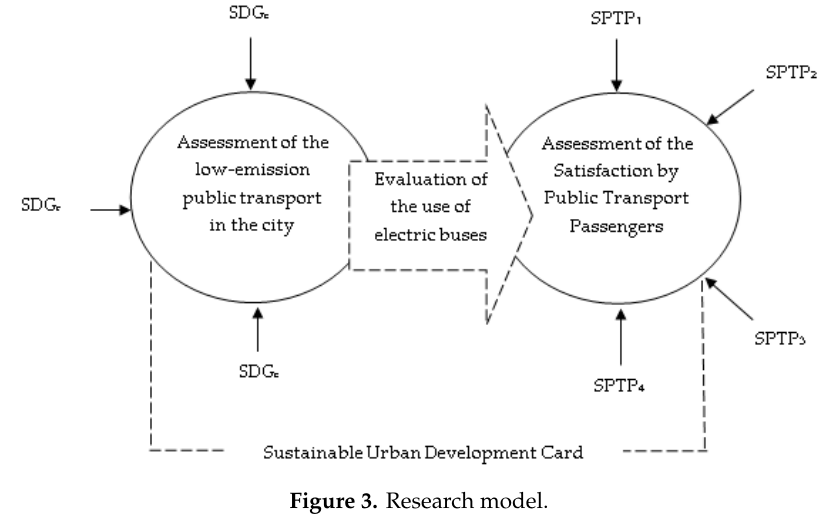
Figure 3. Research model.